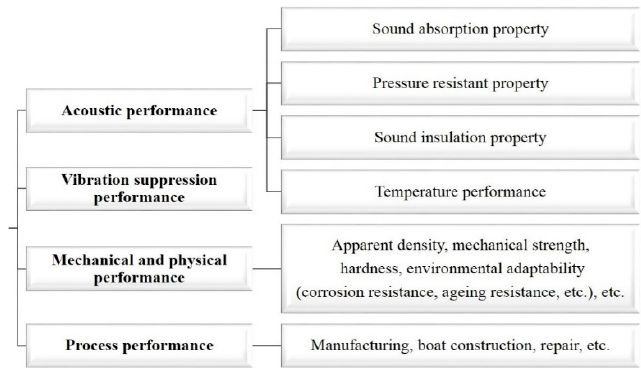
Figure 2. Performance requirements for an acoustic coating [1].